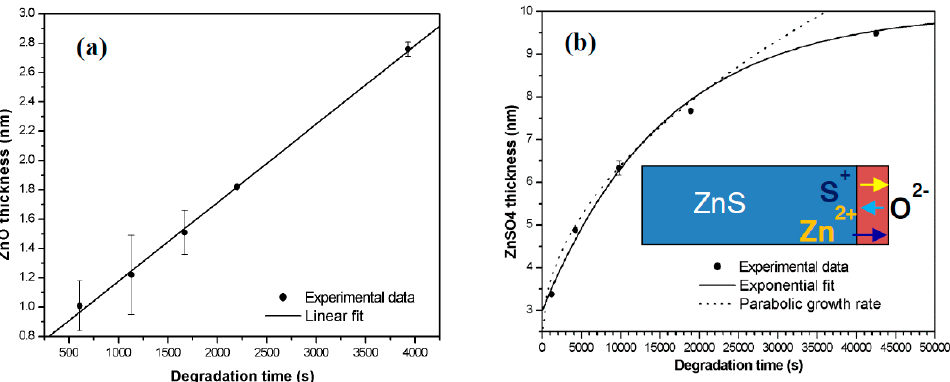
Figure 3. ( a ) ZnSO 4 ; and ( b ) ZnO layer growth in dry and a wet oxygen atmosphere as function of degradation time with an illustration of the diffusion of the charge reactants during the ZnSO 4 formation as an inset [35].